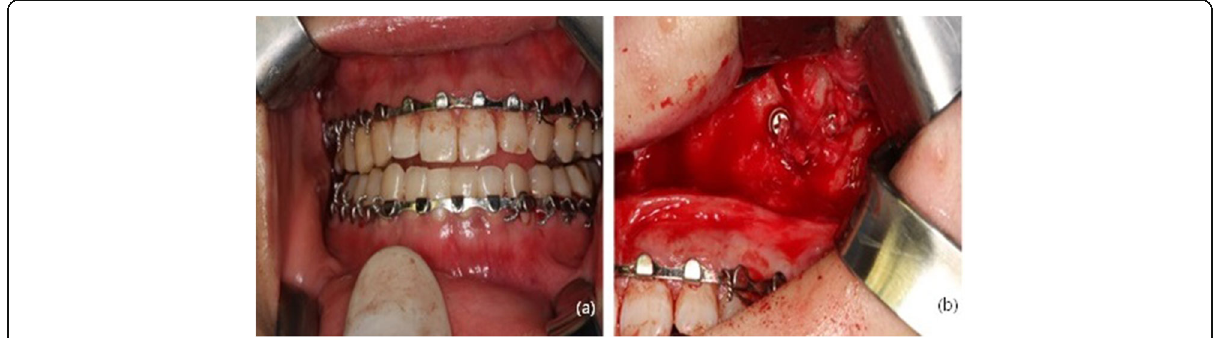
Fig. 2 Clinical photograph during operation. a Severe malocclusion. Before reoperation, an arch bar was applied for intermaxillary fixation. b Upon exposure of the fractured site, malunioned segments with plate and screws were